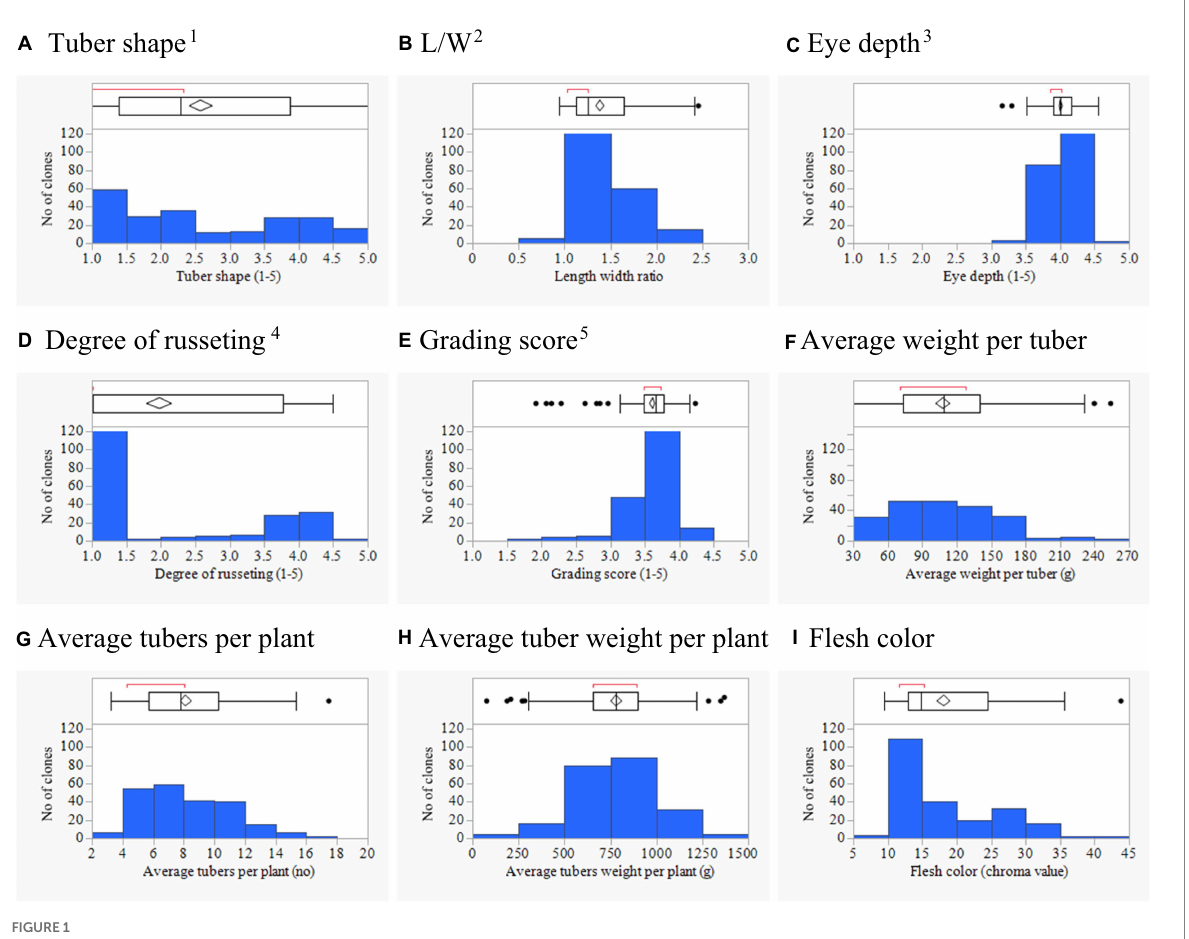
FIGURE 1 Phenotypic distributions of 214 potato clones for tuber shape (A) , L/W (B) , eye depth (C) , degree of russeting (D) , grading score (E) , average weight per tuber (F) , average tuber number per plant (G) , average tuber weight per plant (H) , and flesh color (I) combined across three environments in Texas: Dalhart 2019, 2020 and Springlake 2020. 1 1 = round to 5 = long; 2 1 = deep to 5 = shallow; 3 1 = none to 5 = heavy; 4 1 = poor, 5 = excellent; and L/W = length–width ratio.